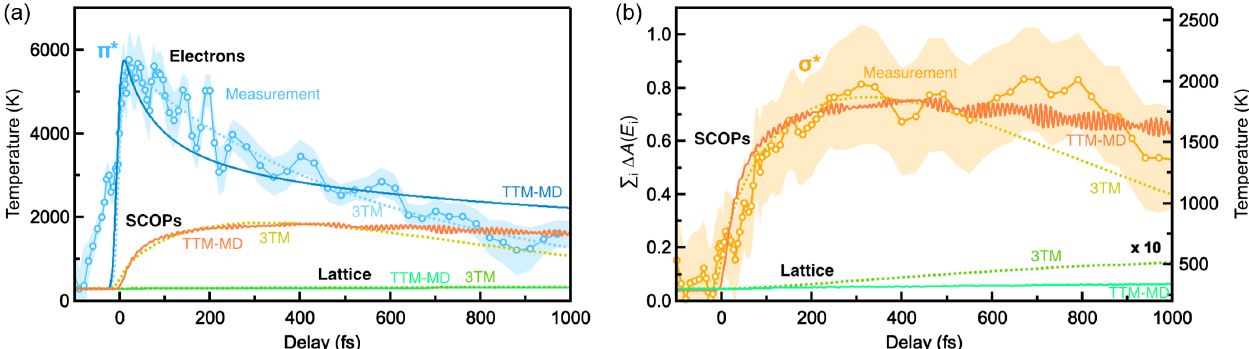
FIG. 5. (a) Temporal evolution of the temperature of the electronic system from a Fermi-Dirac (FD) fit to the experimental data (blue, open circles). The three-temperature model (3TM) fit reproduces the electronic temperature evolution (blue, dotted line) and provides the evolution of the SCOPs (yellow, dotted line) and lattice (dark green, dotted line) subsystems. Overlaid are also results from the TTM MD simulation (solid lines) for all three subsystems. (b) Comparison between the σ (cid:2) experimental signal (yellow, open circles), with SCOPs (red), and lattice (brown) temperatures obtained from the 3TM model in (a). Overlaid is also the result from the TTM MD simulation, confirming the phononic origin of the σ (cid:2) signal. Clearly visible are high-frequency oscillations in the SCOPs which are predicted by the TTM MD model (dark orange, solid line) which are in agreement with the experimental result shown in Fig.